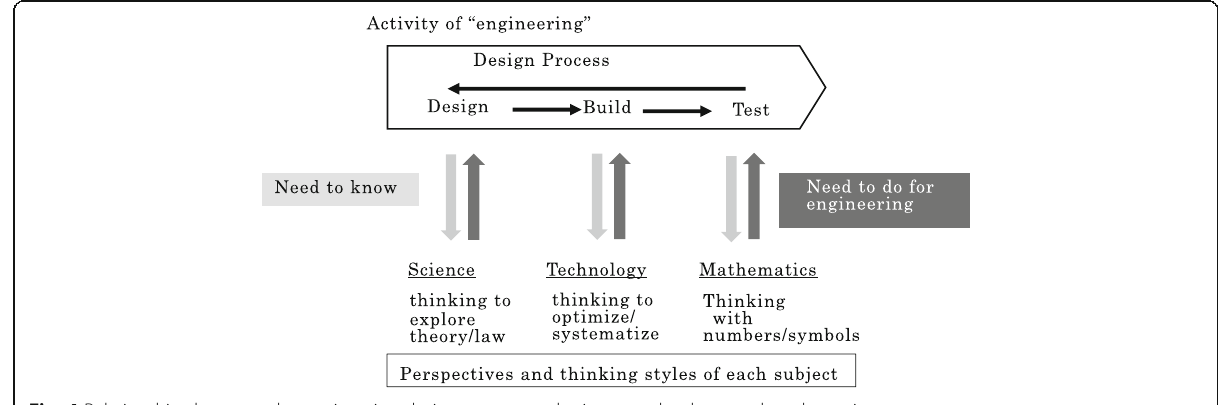
Fig. 4 Relationships between the engineering design process and science, technology, and